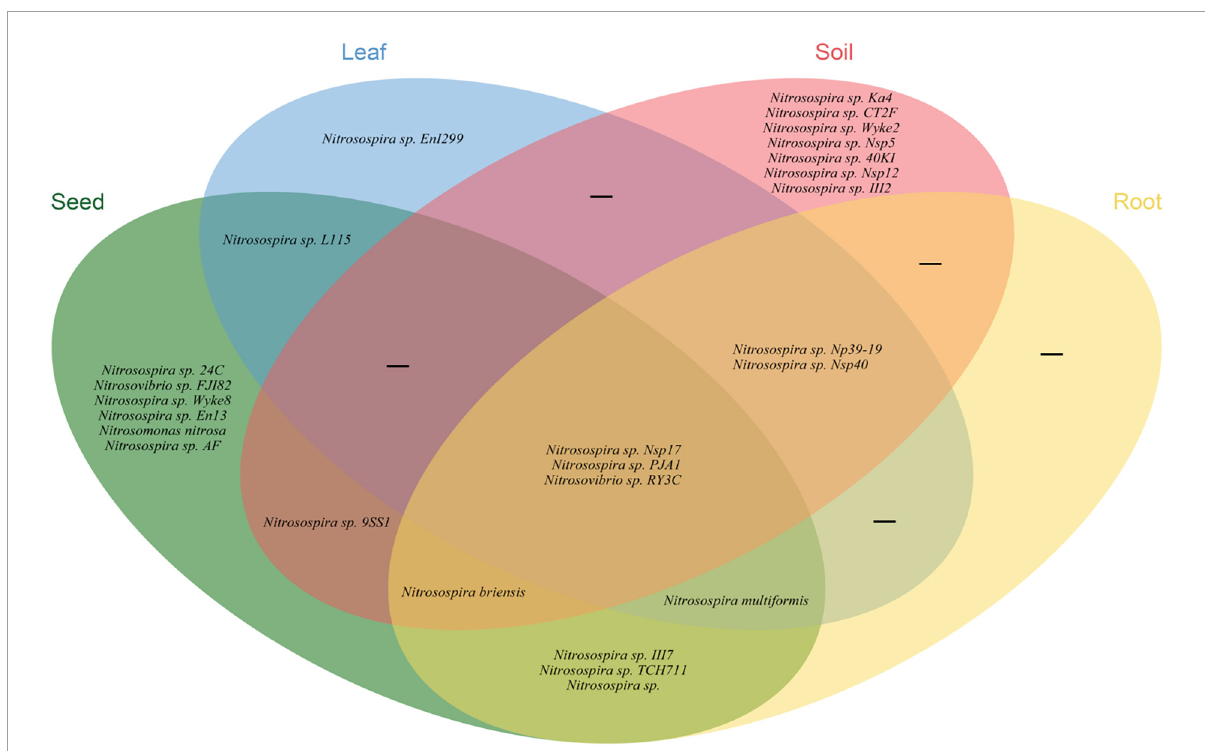
FIGURE2 Venn diagram illustrating the unique, shared and core ammonia oxidizing bacteria in different plant parts and soils of E. nutans growing at Maqu Azi station on the QTP.